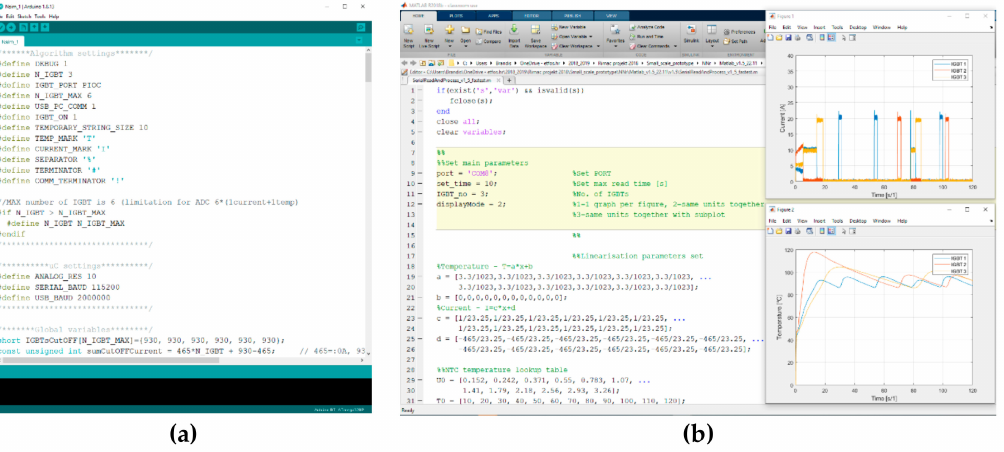
Figure 8. The human-machine interface of the test setup: ( a ) Arduino; ( b )